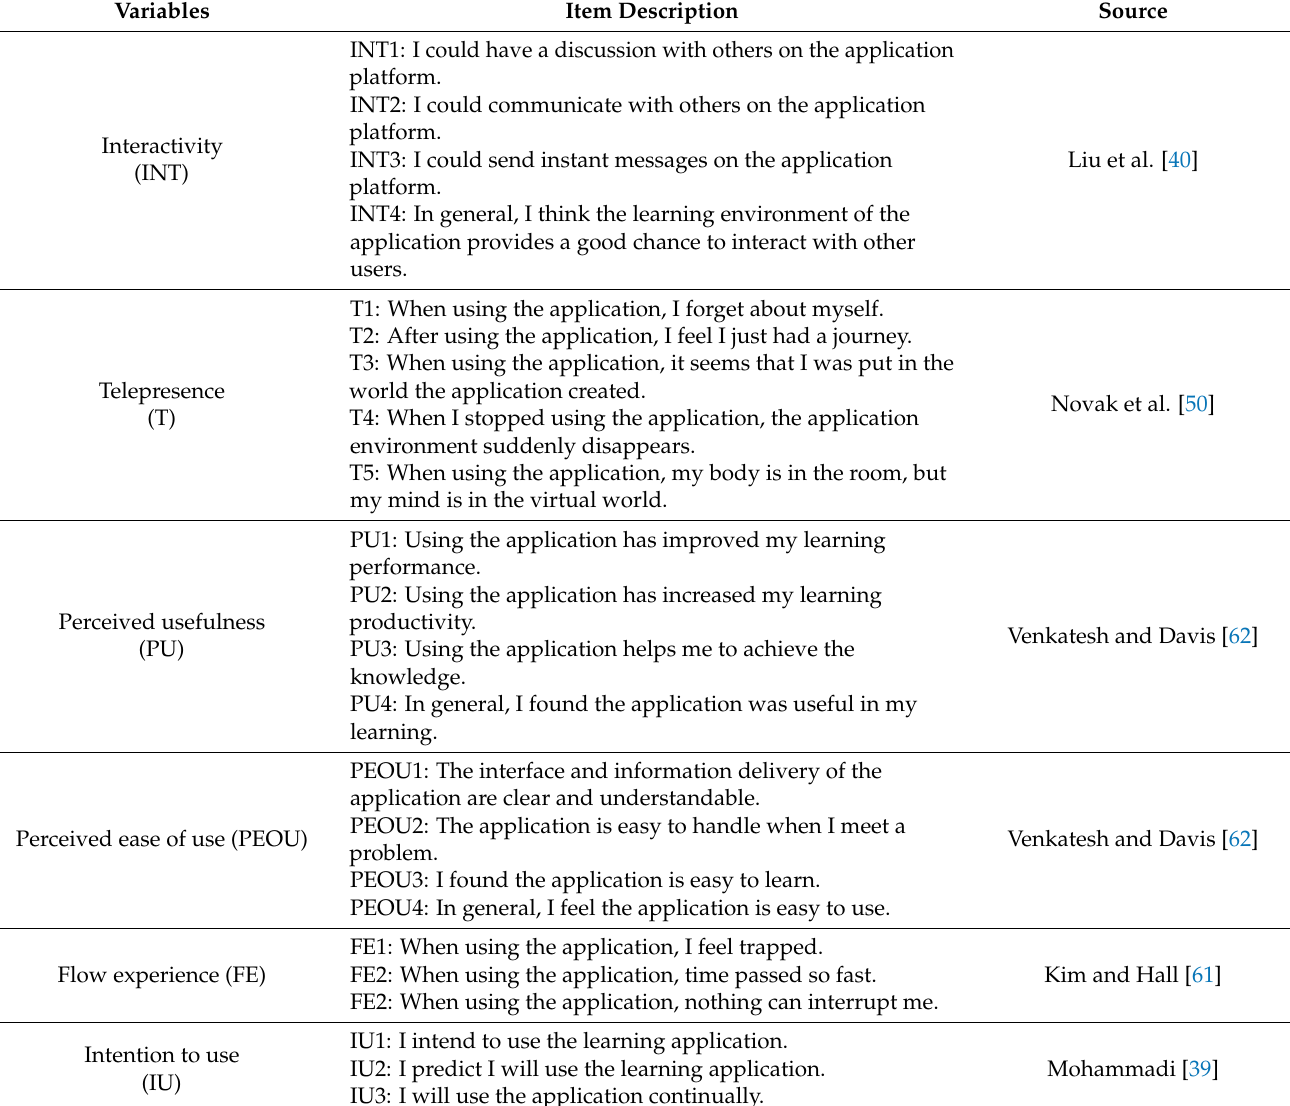
Table 1. Construct measurement for mobile learning application